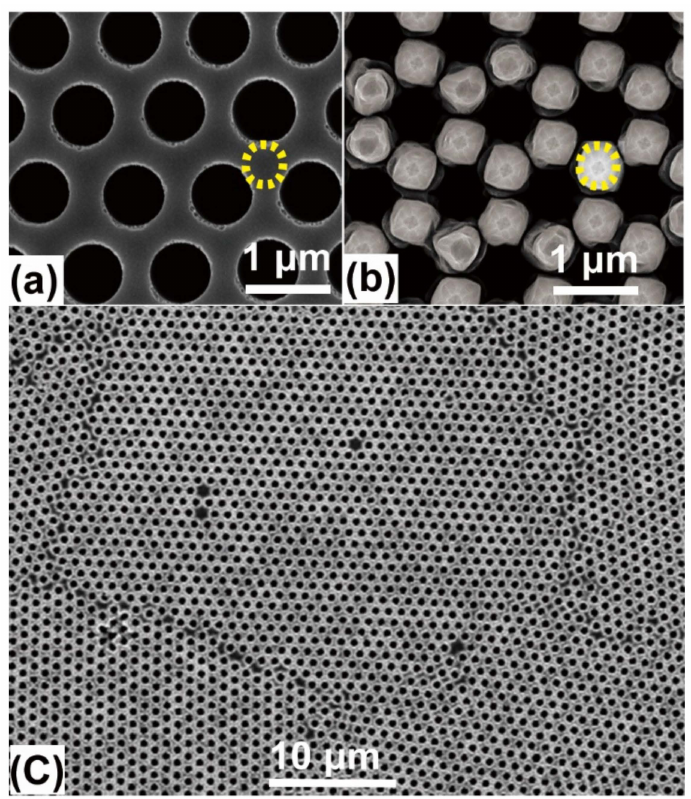
Figure 2. Top-view SEM images. ( a ) Ordered micro-holes on a Si(001) substrate, the micro-hole array after the growth of Si and graded Ge x Si 1 − x alloy via MBE in ( b ) a small area, ( c ) a large area. The yellow dotted circles in ( a , b ) denote the regions in-between three